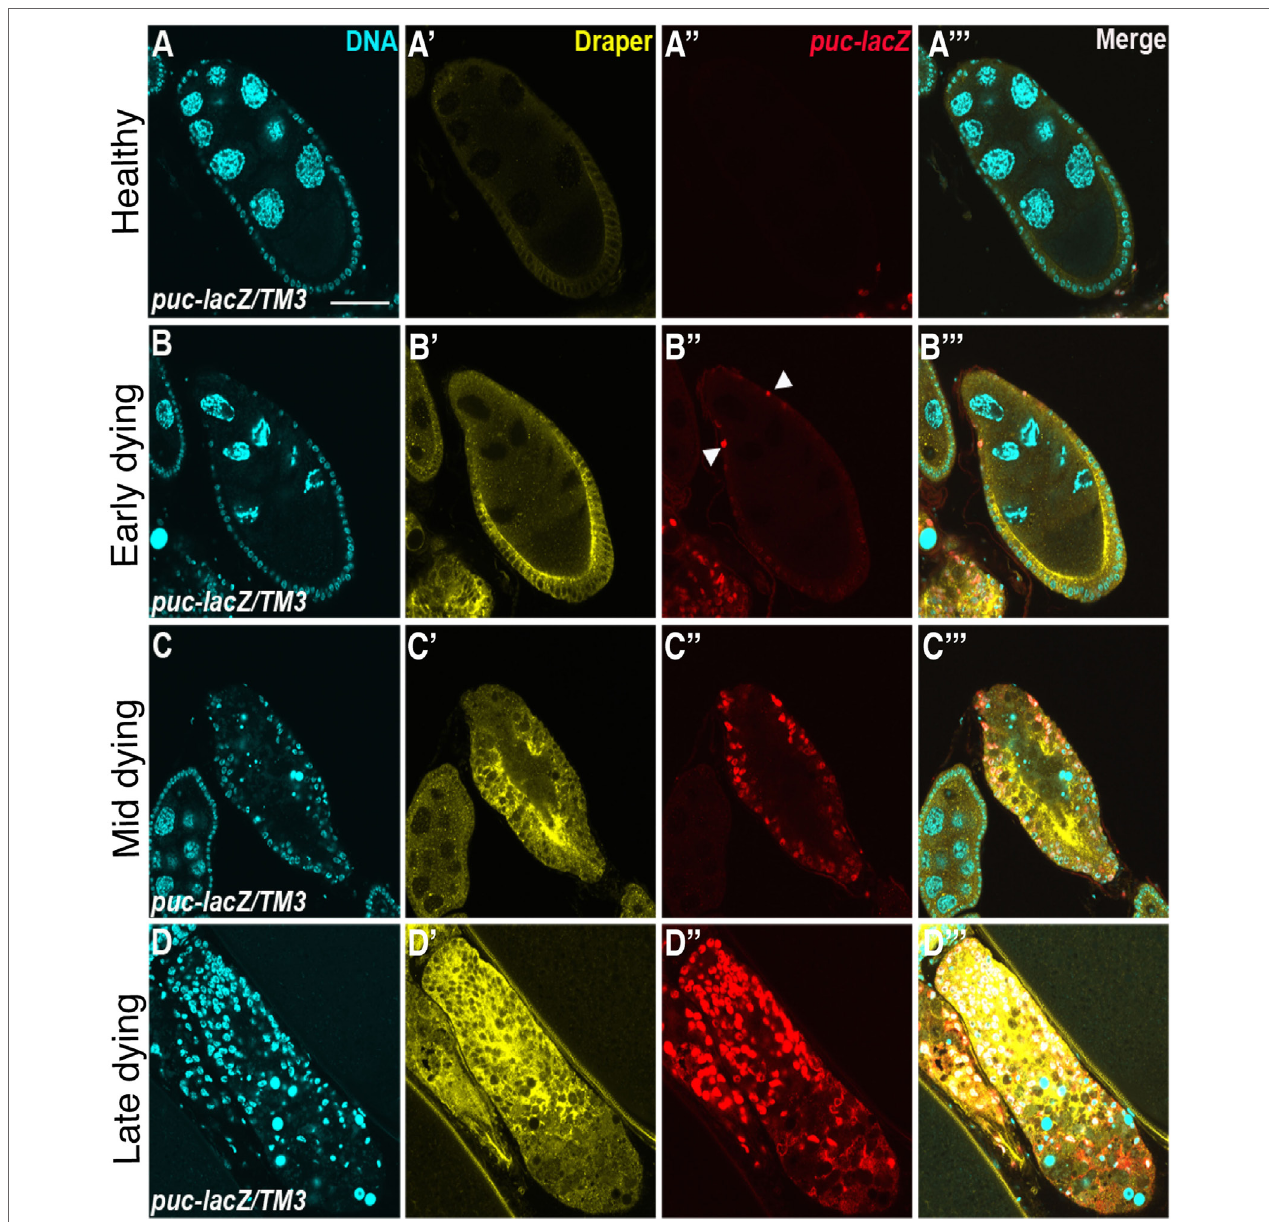
FiGURe 2 | Draper and the JNK signaling pathway are activated in follicle cells during engulfment. Healthy (A) and degenerating (b–D) egg chambers expressing the JNK reporter puc-lacZ, stained with anti-Draper (yellow), anti- β gal (red) and DAPI (cyan). Draper is expressed at low levels in healthy egg chambers (A ′ ) and increases in expression throughout the progression of engulfment (b ′ –D ′ ) . puckered is not expressed in healthy egg chambers (A ″ ) , but is activated during engulfment (b ″ –D ″ ) , merged images are shown in panels (A ′″ –D ′″ ) . Adapted with permission from Ref.